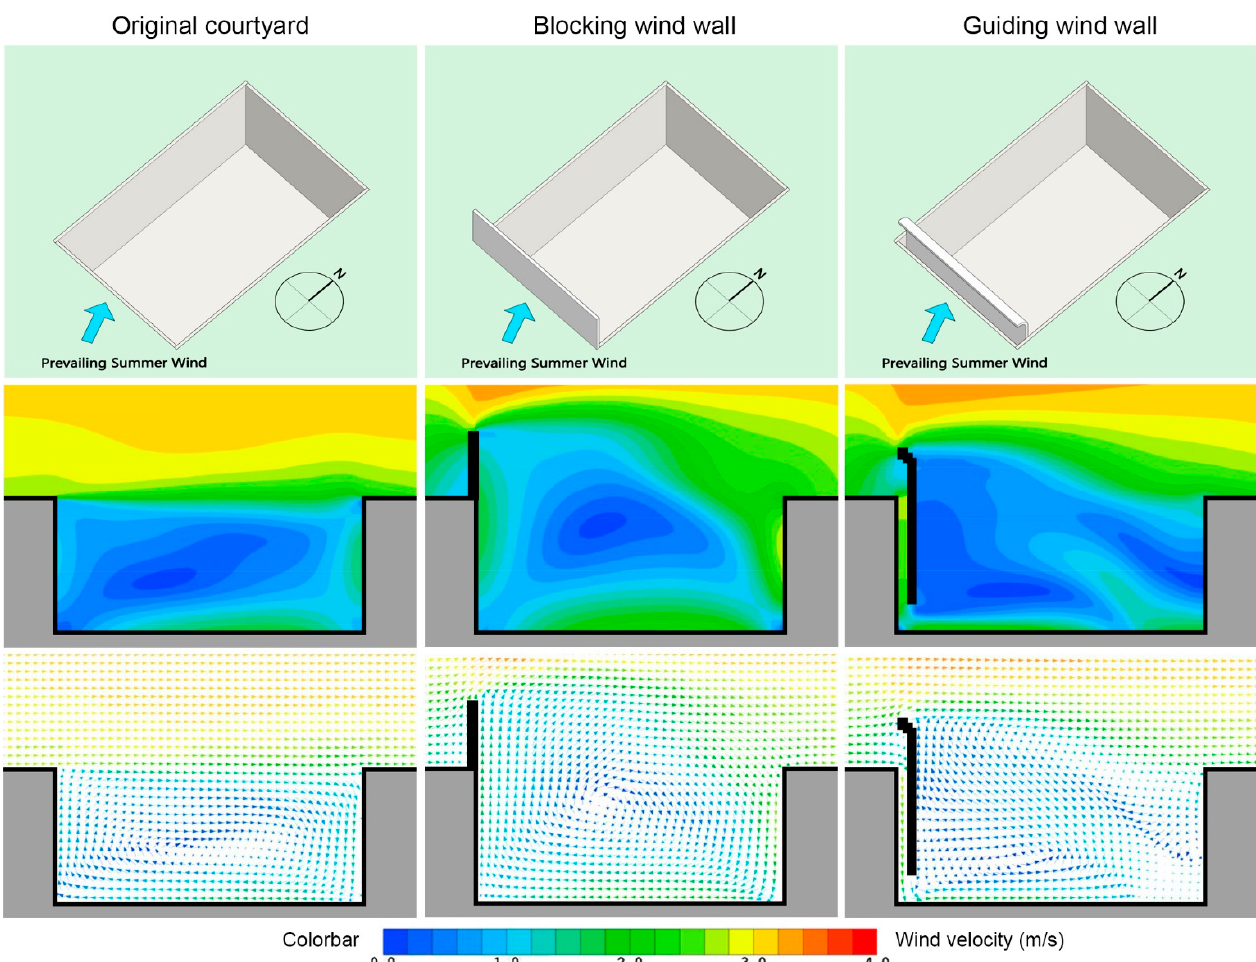
Figure 8. CFD simulation results of improved designs for natural ventilation.